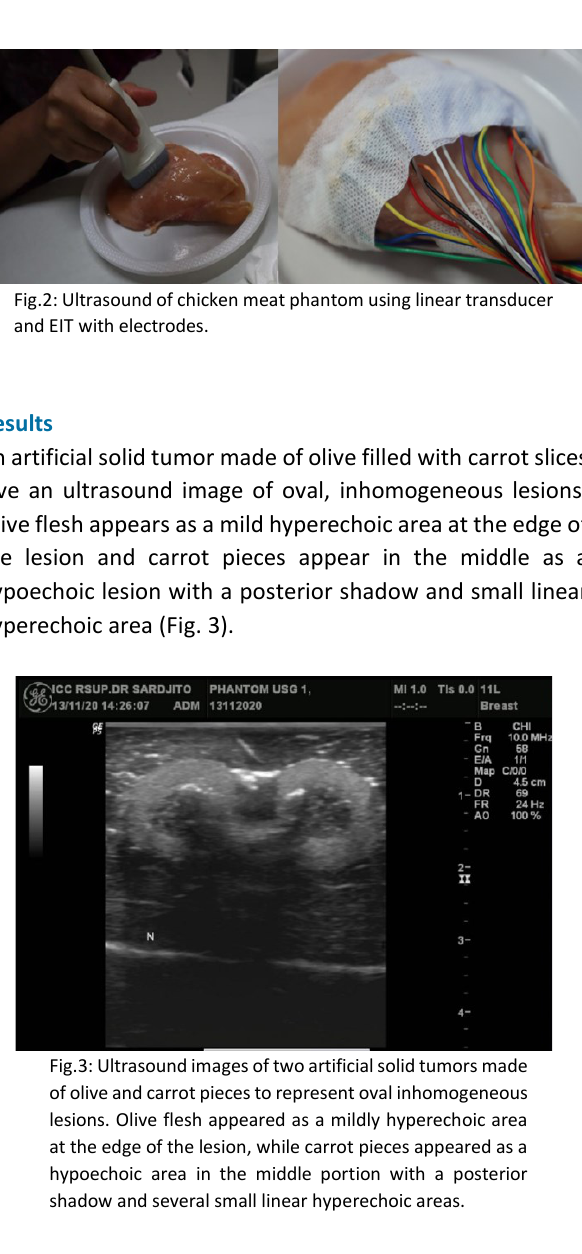
Fig.1: Chicken meat phantom with olive filled with carrot as artificial solid tumor (two green olives) and small balloon filled with water as artificial cystic tumor.